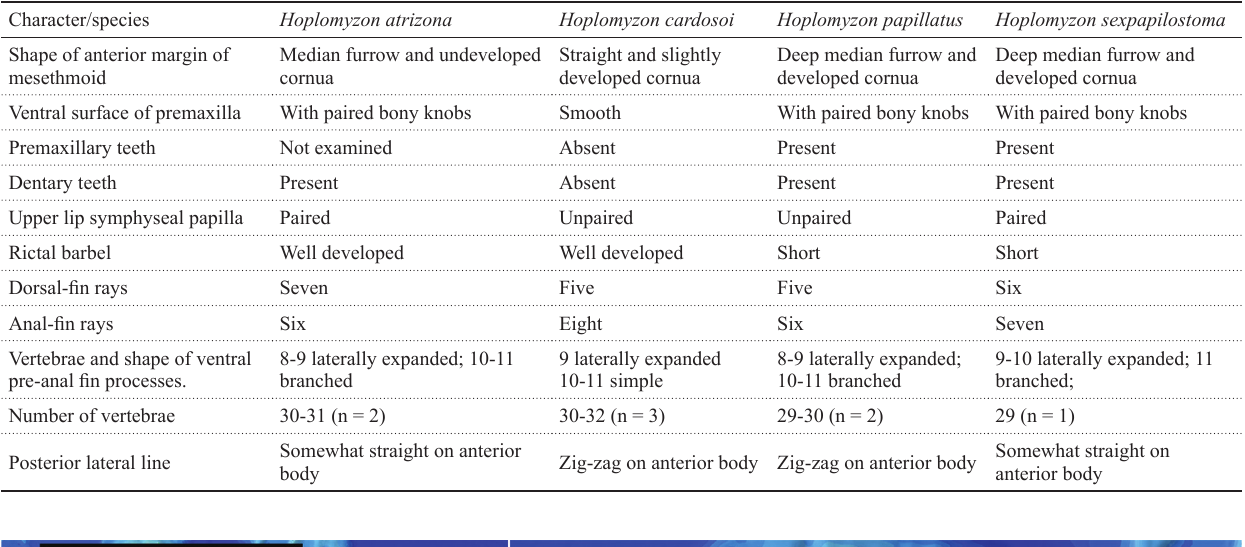
Tab. 2. Summary of characteristics variable within Hoplomyzon species based on examined material and literature (Stewart, 1985; Taphorn, Marrero 1990).